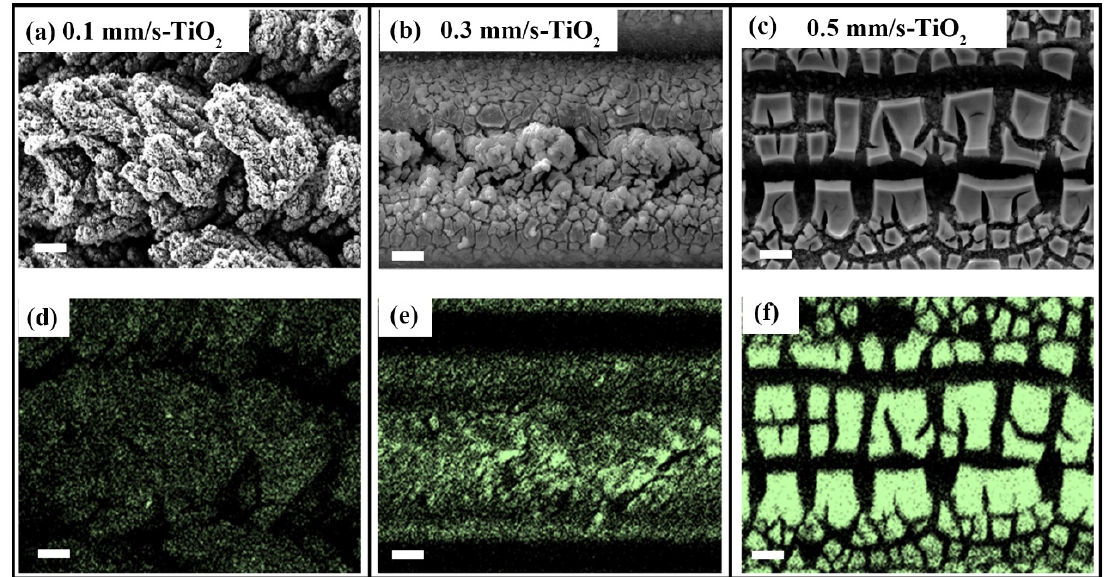
Figure 5. Characterization of the surface morphology and the elemental distribution for the Laser- TiO 2 samples. ( a – c ) Variable morphology profiles at three different scanning speeds after femtosecond laser processing; ( d – f ) Observation of the elemental distribution patterns on the surfaces of three different scanning speeds. The green color for Ti element. Scale bars are 10 μ m.